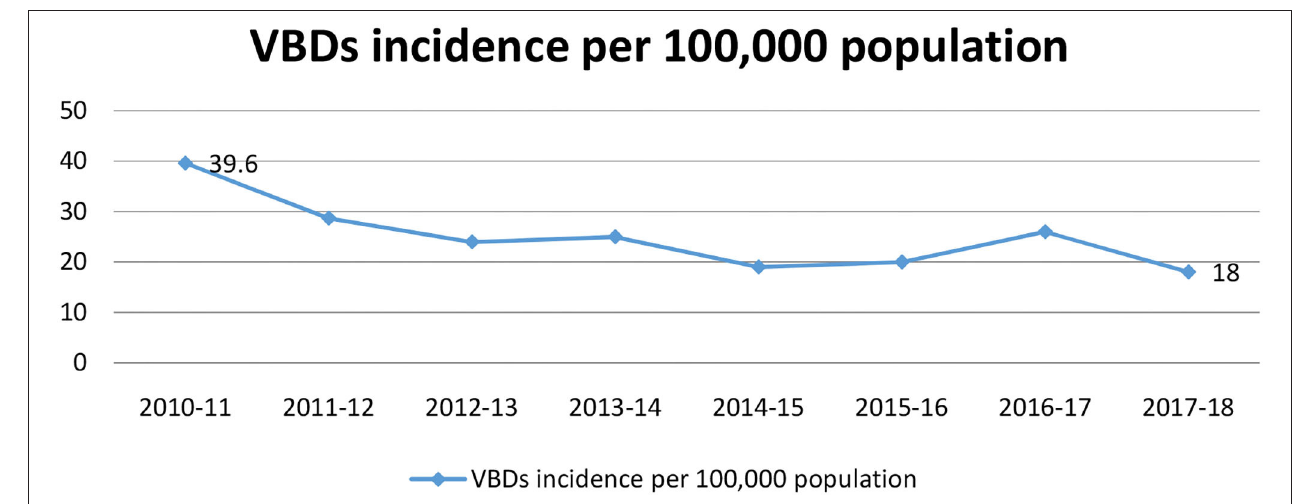
FIGURE 4 | Impact assessment of vector control interventions and decline in burden of VBDs in UP.